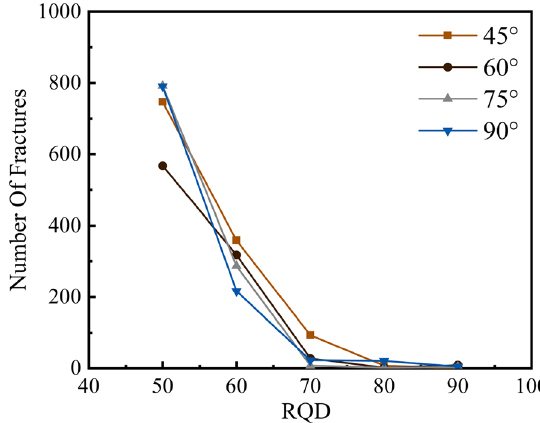
Fig. 33 Number of cracks with different RQD and θ when σ